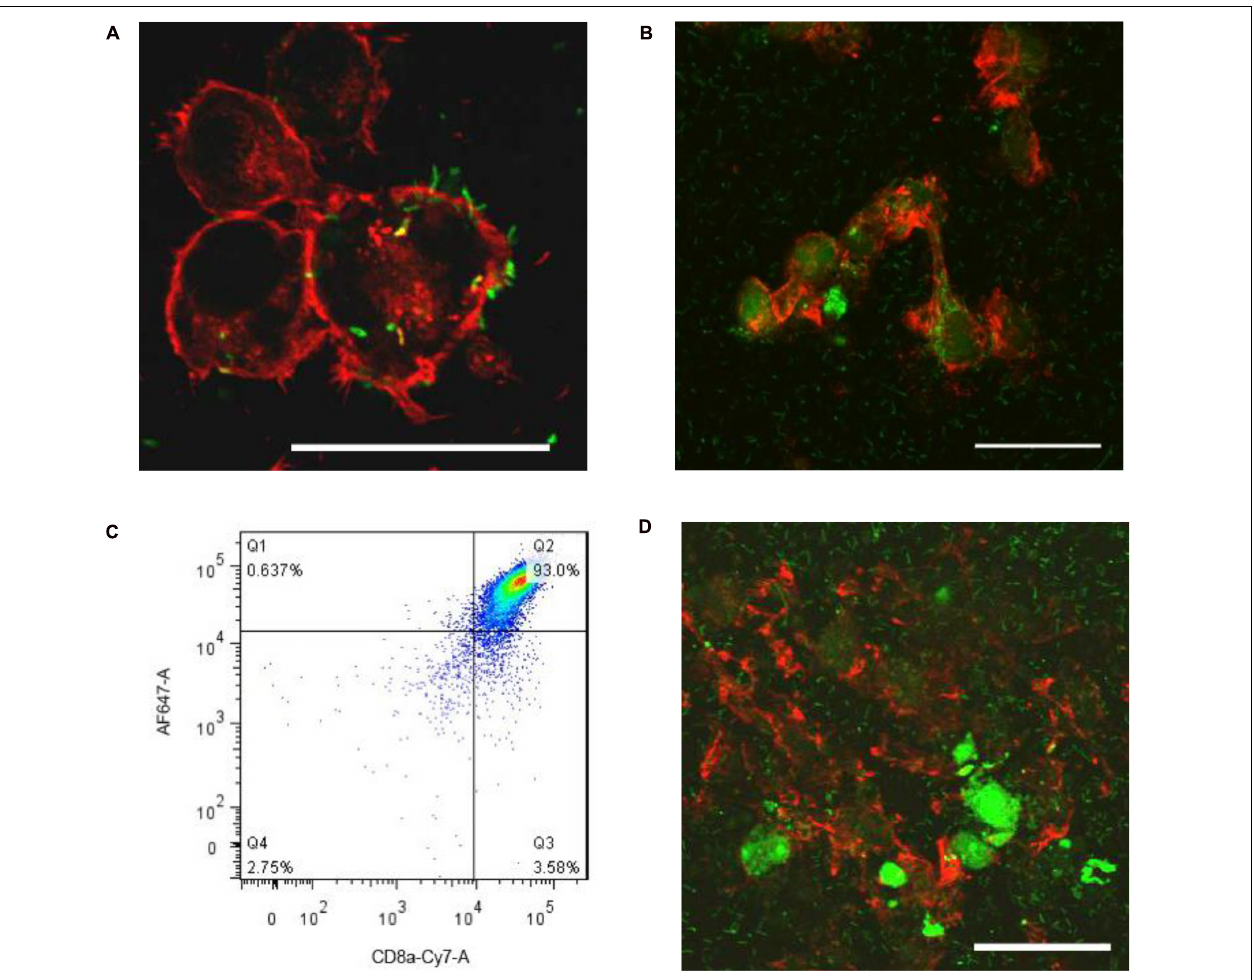
FIGURE 2 | Listeria is transmitted between microglia. BV2 cells were incubated in a confocal dish with serum-free and antibiotic-free medium. Listeria (FITC, MOI = 50:1) was added to BV2 cells and then was incubated in a confocal dish (6 × 10 5 cells). By confocal microscopy, Listeria (arrow) was observed to penetrate the BV2 cells (Rhodamine phalloidin) (A) . Listeria (arrow) spread from cell to cell by remaining intracellular (B) . CD8 + T cells were inspected by flow cytometry (C) . The extracted CD8 + T cells (6 × 10 5 cells) were added to the confocal dish; after 2 h, most of the cells were broken, and Listeria entered the culture medium (D) . Scale bars = 50 µ